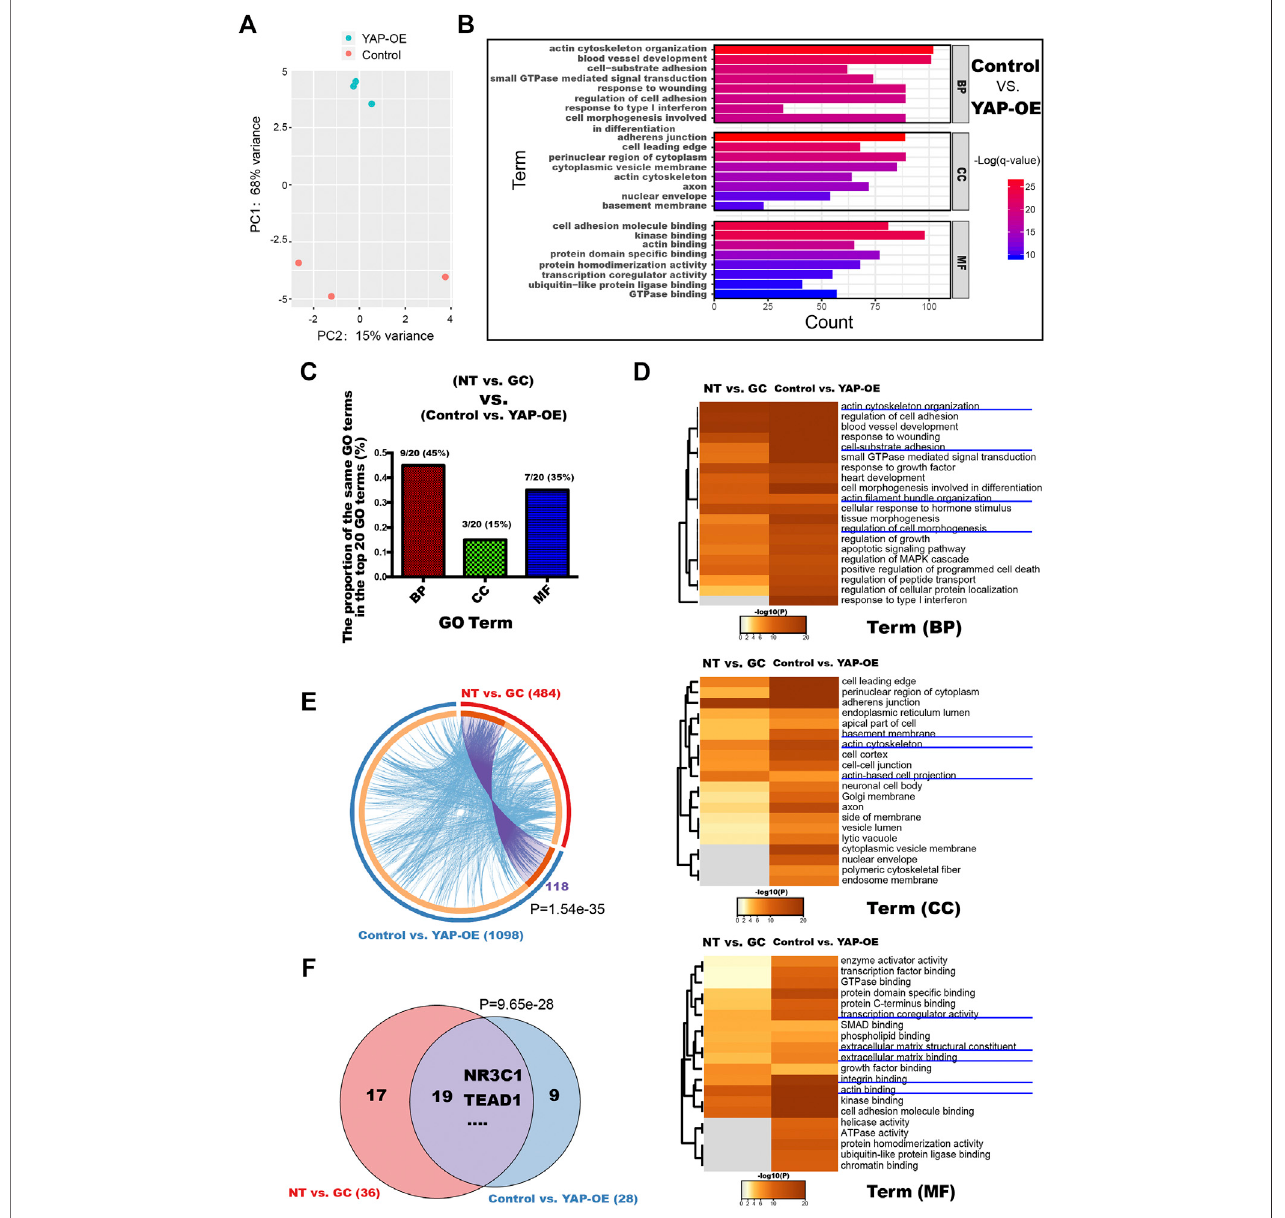
FIGURE 6 | YAP is a key molecule related to ECM component expression and morphological changes induced by GCs in HRCECs. (A) : PCA was performed on samplesfromtheYAP-OEvs.controlcomparison.HRCECswereculturedinRPMI1640medium(Gibco)containing10%FBS(Gibco)for72 handthentransfectedwith YAP-OEorcontrollentiviralvectorsfor48 h. (B) :Topsigni fi cantlyenrichedGOtermsfortheDEGsbetweenthecontrolgroupandYAP-OEgroupfortheBP,MFandCC categories. (C) :Theproportion ofthesameGOtermsinthetop20signi fi cantlyenriched GOtermsbetweentheNTvs.GCgroupsand controlvs.YAP-OEgroups for the BP, MF and CC categories. (D) : Dendrogram of the enriched GO BP, CC and MF terms across the DEGs from the NT vs. GC and YAP-OE vs. control comparisons.Theheatmapcells arecoloredbytheir p values. (E) :Geneoverlap analysis.TheCircos plotshows howtheDEGs fromtheNTvs. GCcomparison and the YAP-OE vs. control comparison overlap. Purple lines link the same gene that is shared by multiple gene lists. Blue lines link different genes associated with the same ontology term. A greater number of purple links and a longer dark orange arc imply greater overlap among the input gene lists. The blue links indicate the amount of functional overlap among the inputgene lists. (F) : Venn diagrams showing the TF number overlap inthe TF binding site enrichmentanalysisof DEGs from the NT vs. GC and YAP-OE vs. control comparisons. The analysis was performed with a web-accessible software program called oPOSSUM-3. In (E) and (F) , p indicates the p -value of the overlap in Venn diagrams and Circos plot from Fisher ’ s exact test. DEGs differentially expressed genes, GO Gene Ontology, BP biological process, CC cellular component, MF molecular function, TF transcription factor.